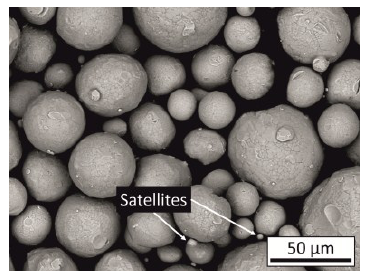
Figure 1. SEM image (Secondary electron mode, 15 kV) showing the spherical shaped Ti-45Nb gas atomized powder (GAP) particles with the presence of satellites.